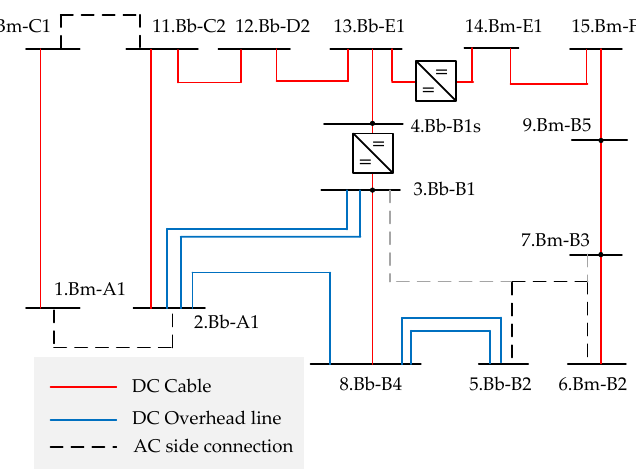
Figure 8. Single-line diagram of CIGRE B4 DC grid test system.